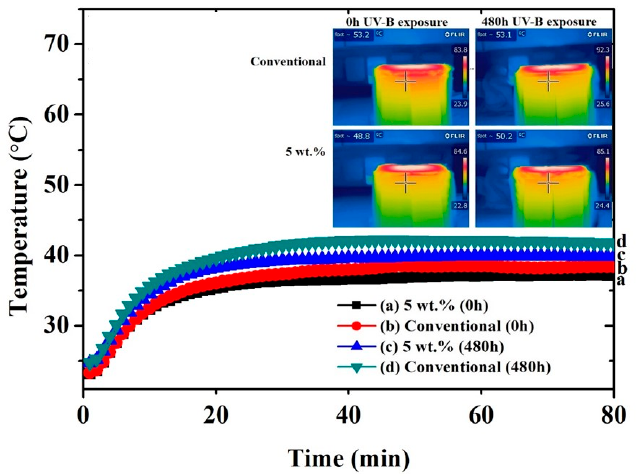
Figure 7. Thermal measuring points for yellow coatings (inner surface of roof panel) obtained with a thermocouple and an IR camera.